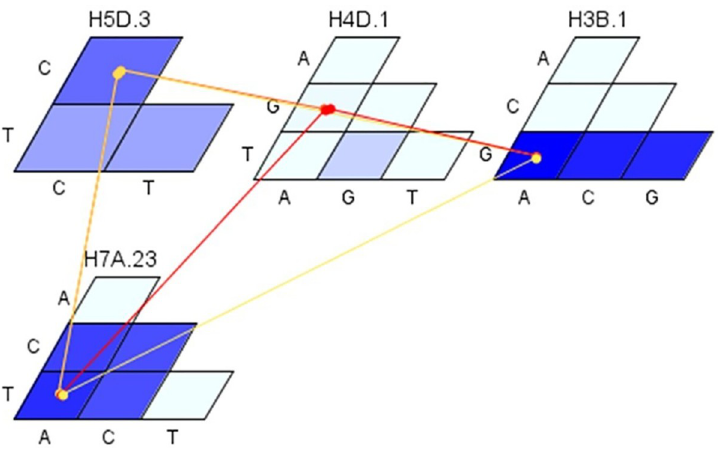
Fig 12. Additive-Additive interactions among loci associated with SR resistance. The magnitude/effect of interaction is presented with colors from yellow to red (stronger interaction). The haplotype H3B.1 is significantly involved in the Additive-Additive interaction effect with haplotypes H4D.1 and H7A.3.